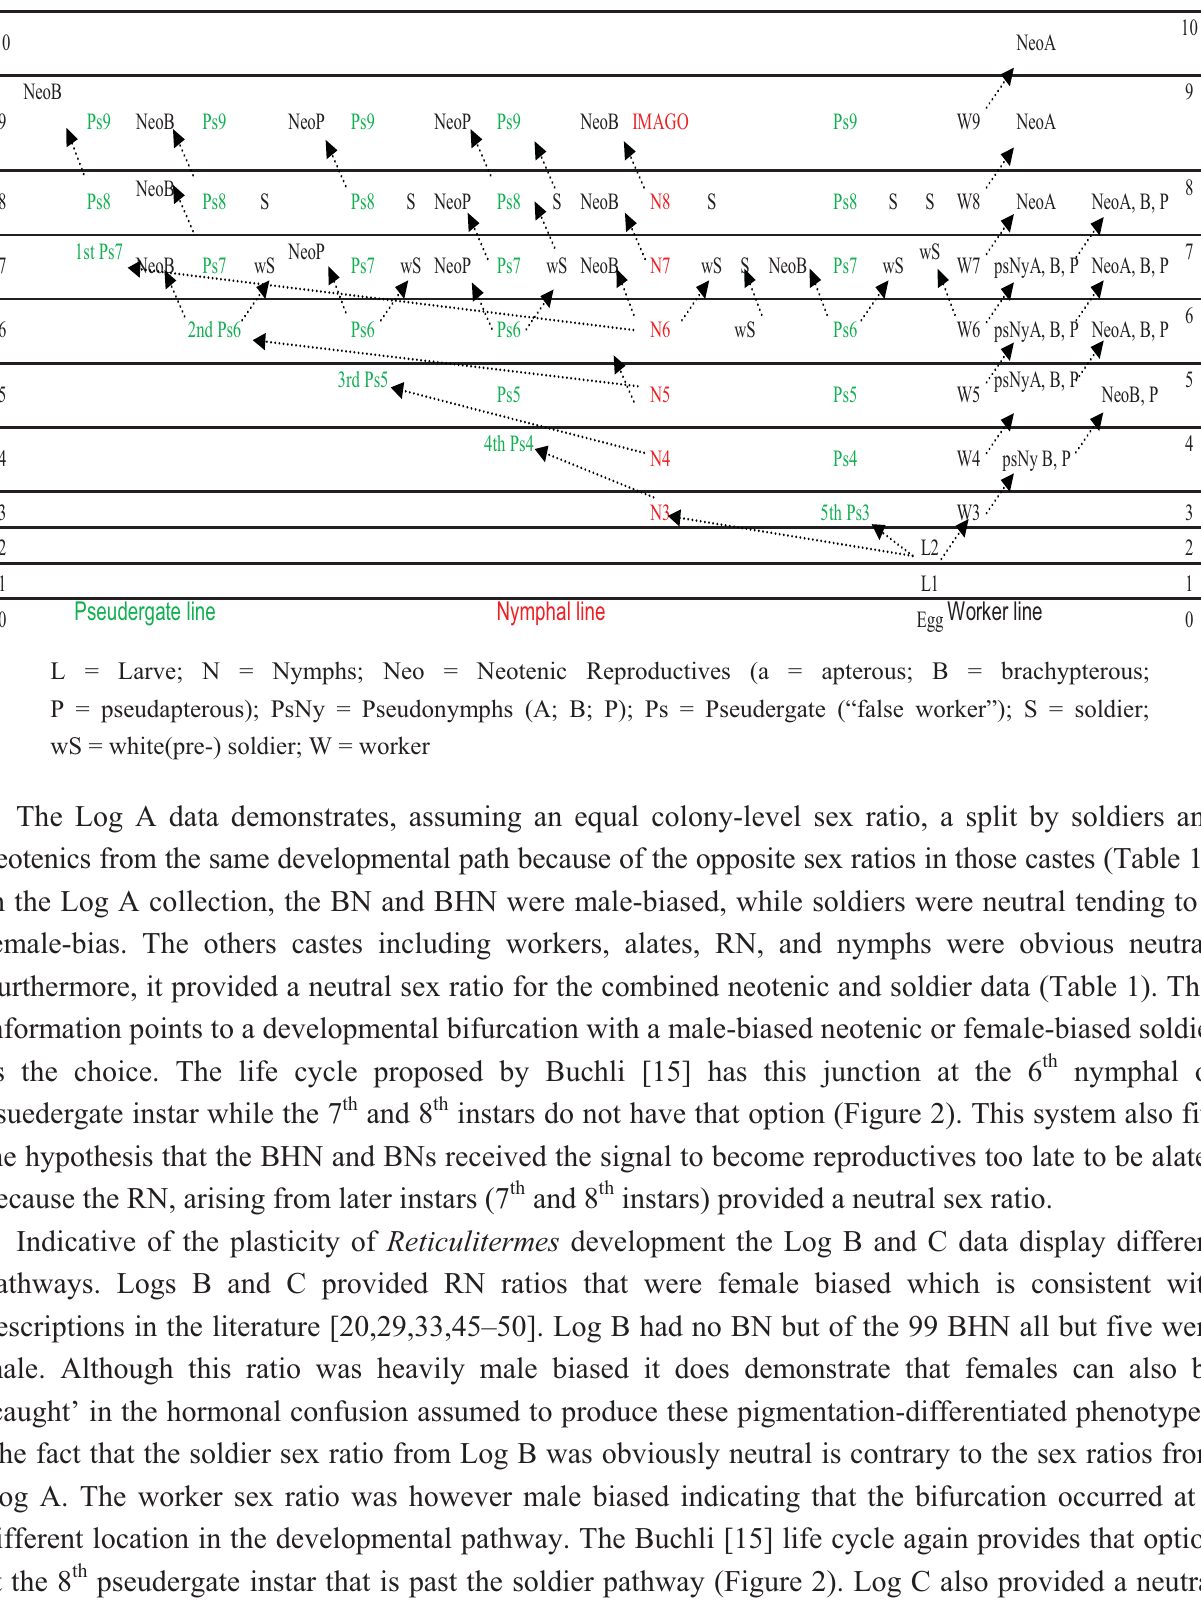
Figure 2. Diagram of Reticulitermes developmental pathways modified from Buchli